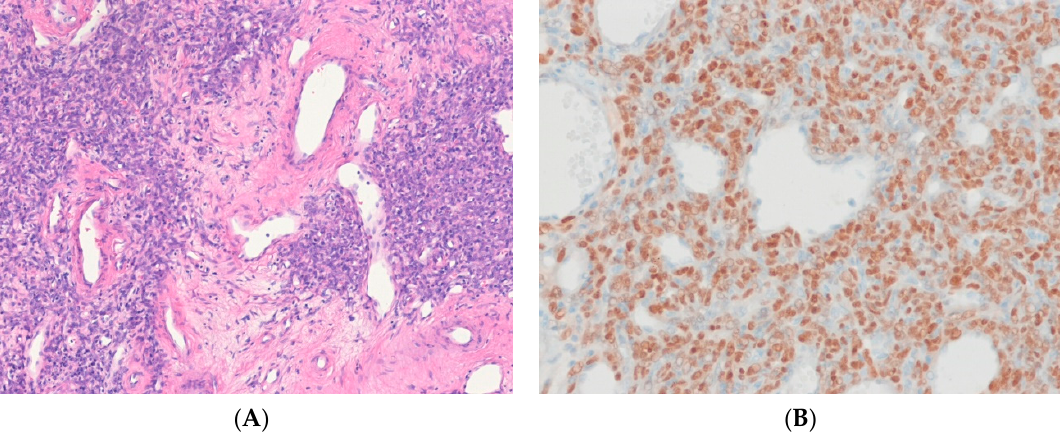
Figure 2. Solitary fi brous tumor. ( A ) The tumor shows spindle to ovoid cells with hypocellular and hypercellular areas and a hemangiopericytoma-like vascular pa tt ern (H&E stain, ×100). ( B ) The tu- mor cells show di ff use nuclear positivity for STAT6, suggesting the presence of an underlying NAB2 :: STAT6 fusion gene (immunohistochemical stain for STAT6,